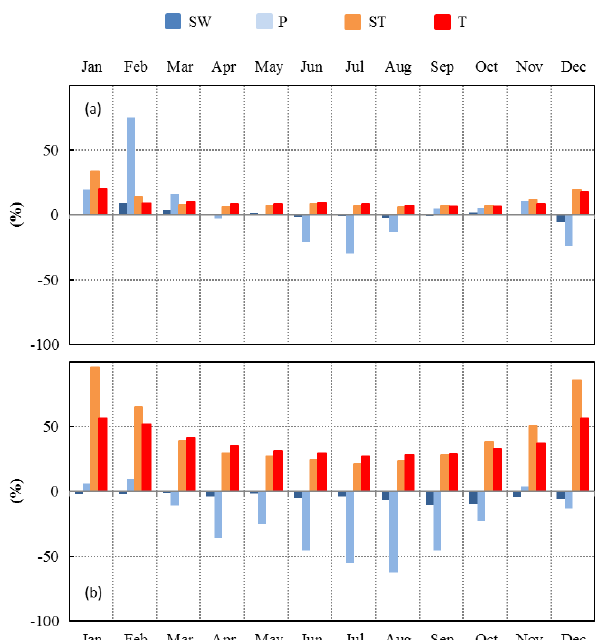
Figure 7. Seasonal variations between present (2000–2010) and fu- ture (2090–2100) relative changes of SW, P , ST, and T over the continental Mediterranean area obtained using (a) RCP2.6 and (b) RCP8.5